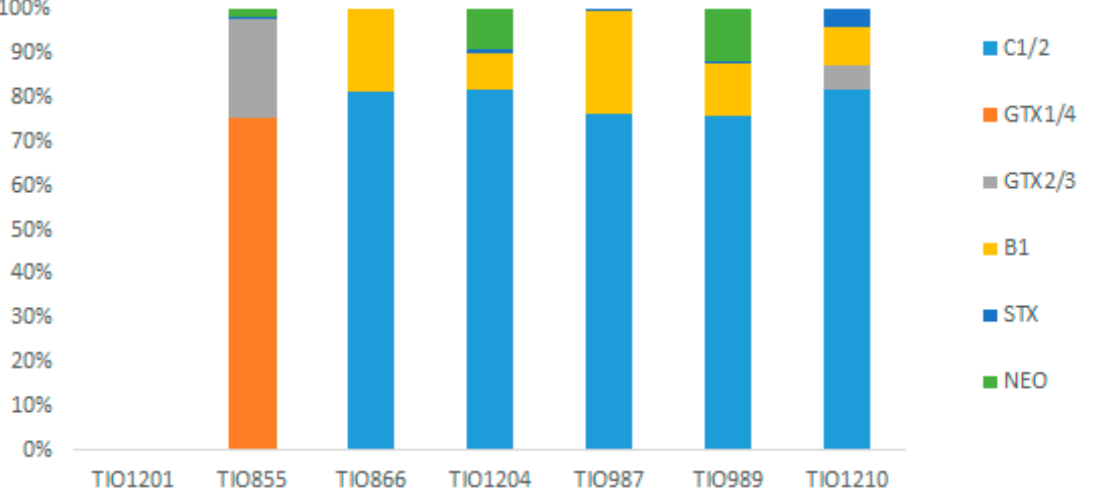
Figure 8. Histograms showing the relative PSP toxin composition (mol %) of Alexandrium pacificum strains. Strain TIO1201 did not produce detectable PSP toxin.